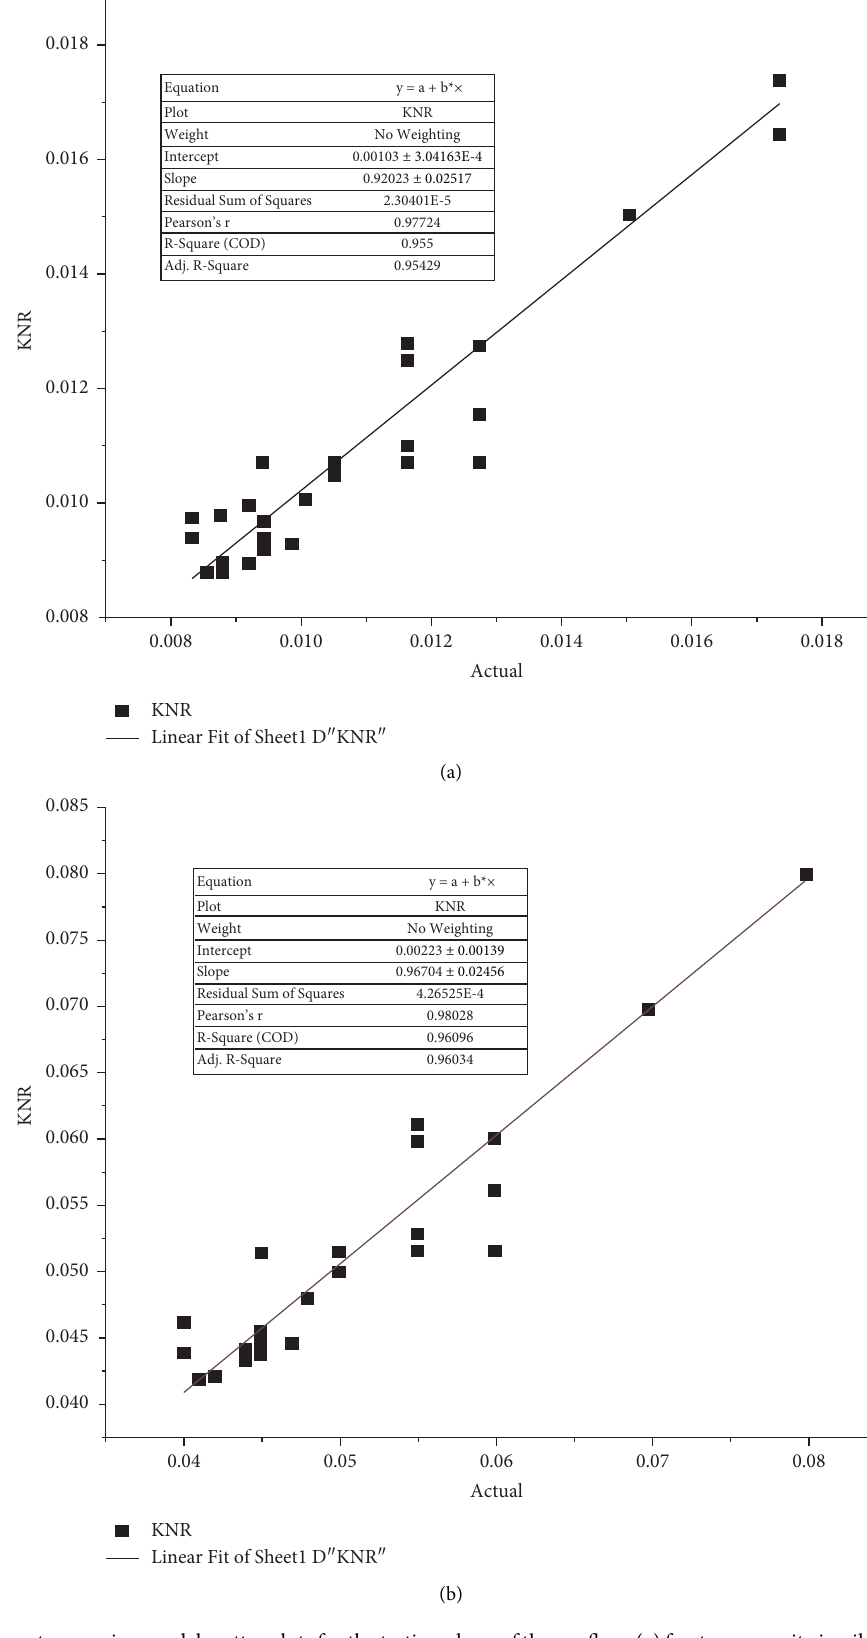
Figure 7: Te K-nearest regression model scatter plots for the testing phase of the gas fow: (a) fracture porosity in oil system and (b) fracture